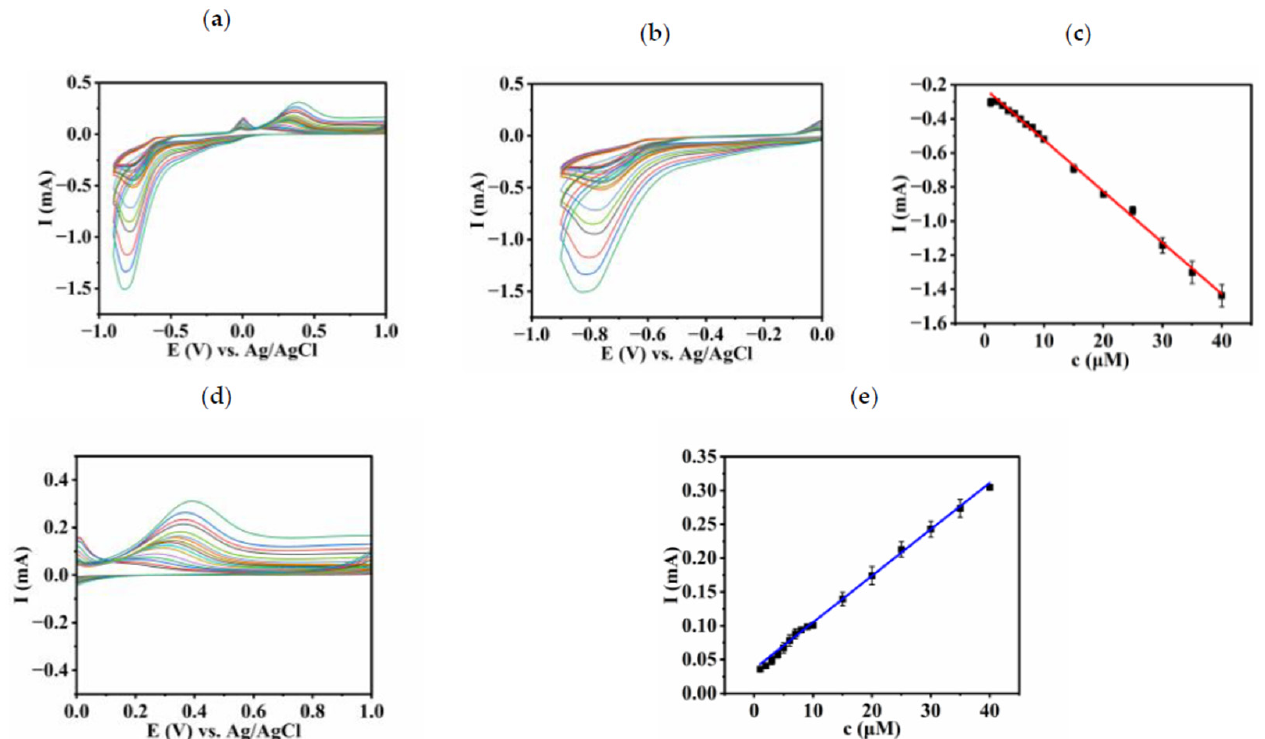
Figure 10. CVs of the ITO/(Cu 4 P 4 W 30 /PDDA-GO) 7 electrode in different concentrations of 2,4-DNPH (1–40 µ m) ( a ); CVs in the potential range from 0 to − 0.9 V ( b ) and the linear relationship between reduction peak currents and concentration of 2,4-DNPH (1–40 µ m) ( c ); CVs in the range from 0 to 1.0 V ( d ) and the linear relationship between the oxidation peak currents and concentration of 2,4-DNPH (1–40 µ m) ( e ) at pH 7.0 with scan rate of 50 mV · s − 1 . Table 1. Comparison of different materials for 2,4-DNPH detection.